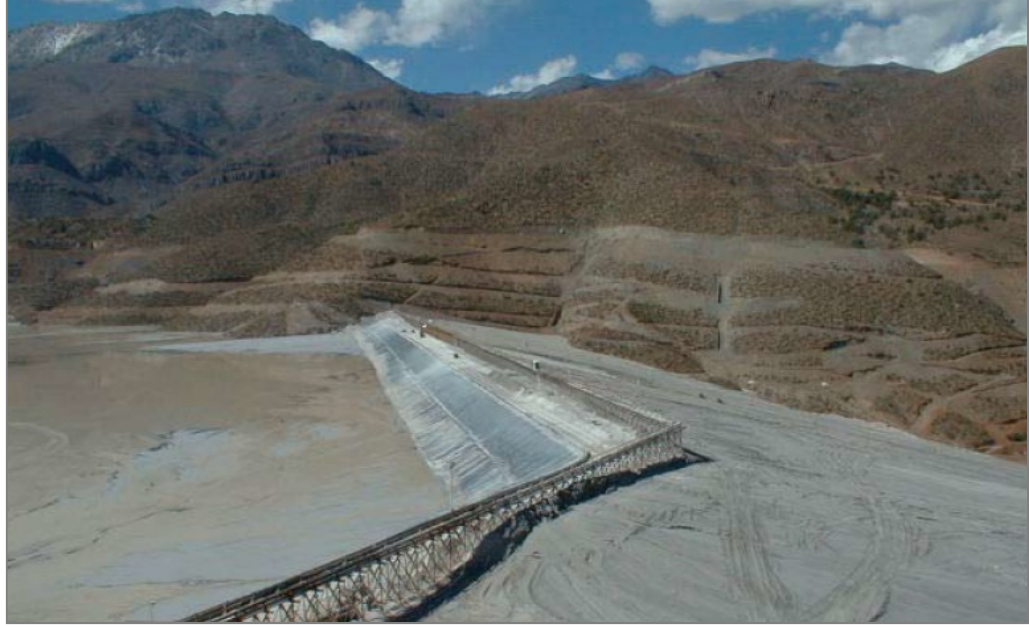
Figure 6. Copper mine tailings management–partially lined TSF—Los Quillayes TSF, Chile.